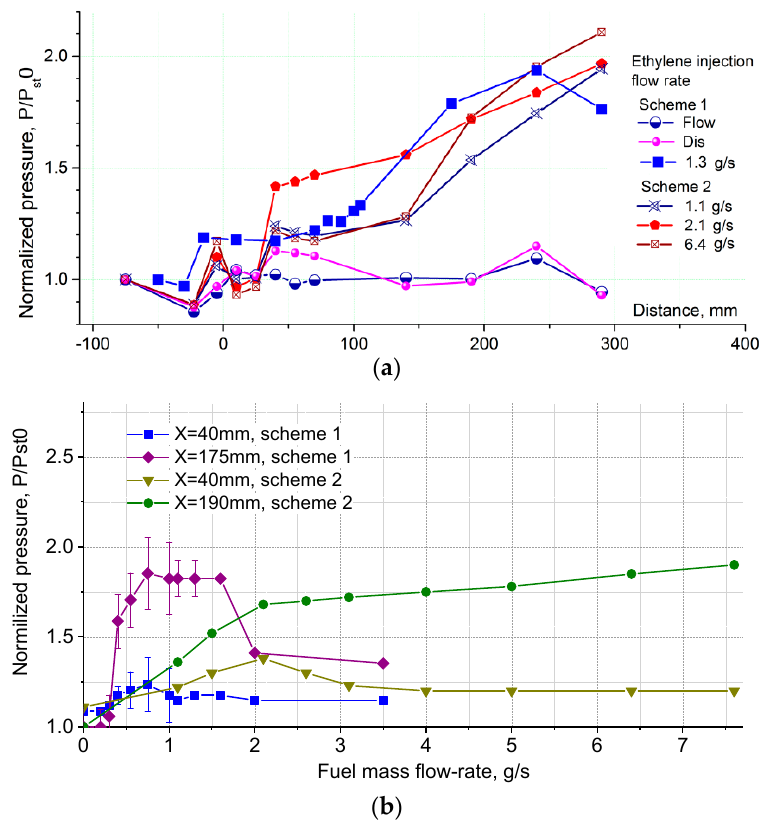
Figure 10. Normalized pressure distribution, scheme 1 vs. scheme 2: ( a ) along the test section at variation of fuel mass flow rate; ( b ) at two locations vs. fuel mass flow rate. For ( a ) the legend “Flow” means “no fuel/no plasma” case, “Dis” means “no fuel/plasma on” case.